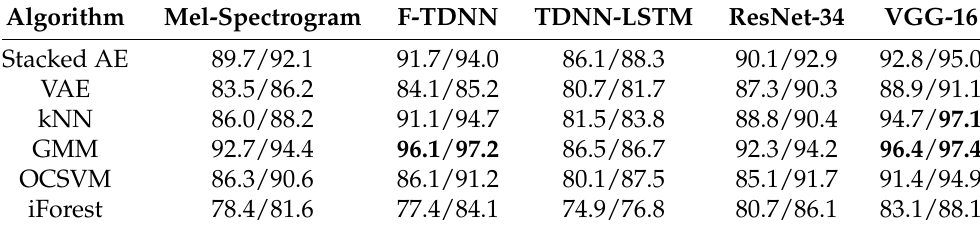
Table 1. The Average F1/AUC Scores of AND on Domestic dataset.